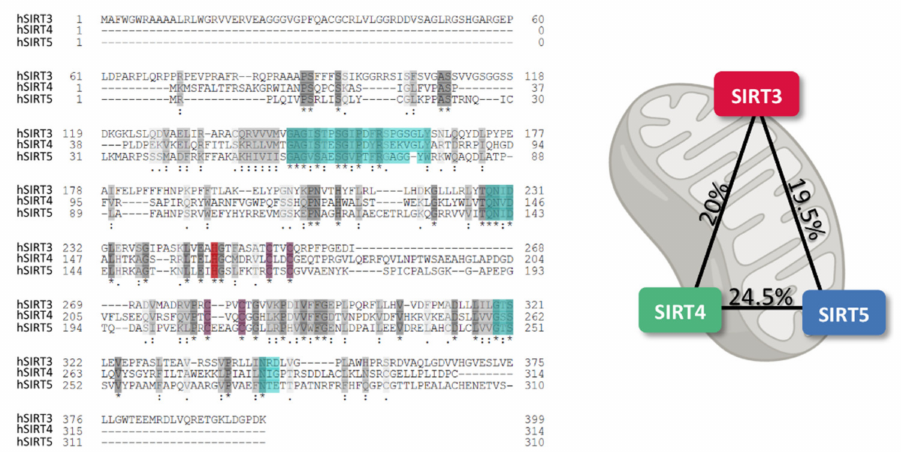
Figure 1. Multiple alignment with sequence similarities (grey), nucleotide binding sites (cyan), zinc-binding residues (purple), and active sites (red), shared by human mtSIRTs (hSIRT3-5) (left panel), and identity percentages among hSIRT3-5, as calculated by Clustalo (right